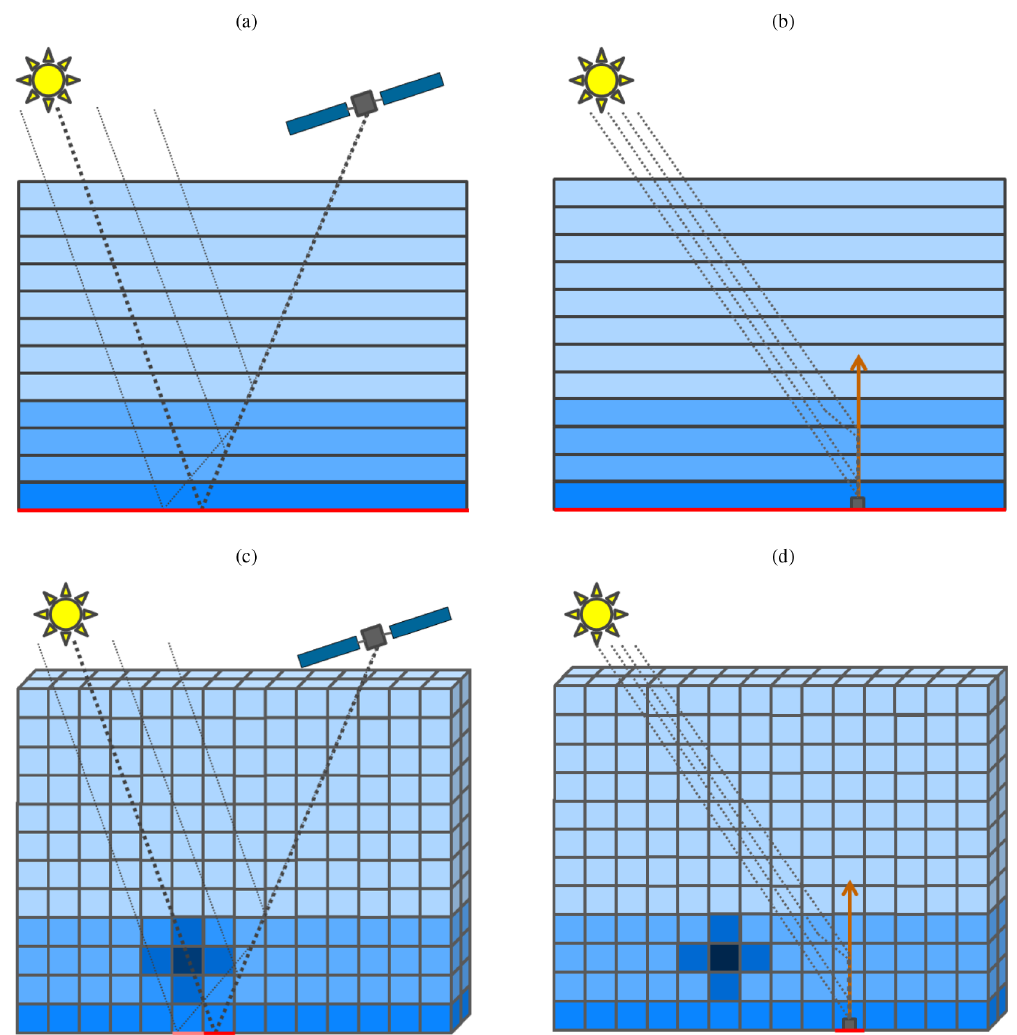
Figure 1. Illustration of the difference between (a, b) 1D-layer and (c, d) 3D-box AMFs for two scenarios with (a, c) downward-looking spaceborne and (b, d) upward-looking ground-based observations. Selected photon paths are shown as dashed lines. The 1D-layer AMFs implicitly assume horizontally uniform atmospheric and surface properties, whereas 3D-box AMFs fully account for both vertical and horizontal